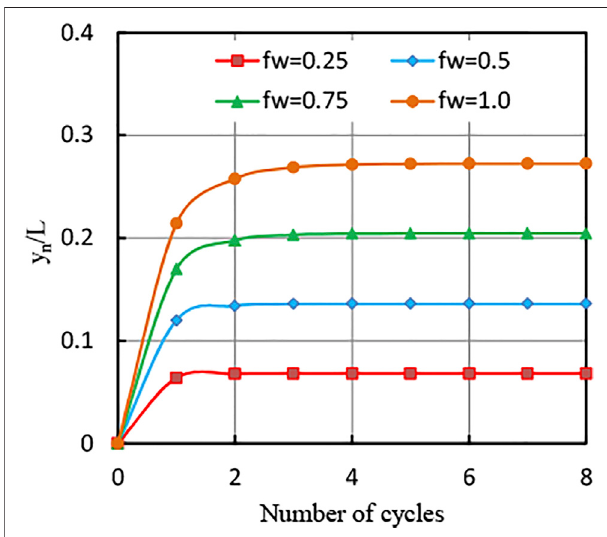
FIGURE 9 | Variations of y n / L with the number of wetting – drying